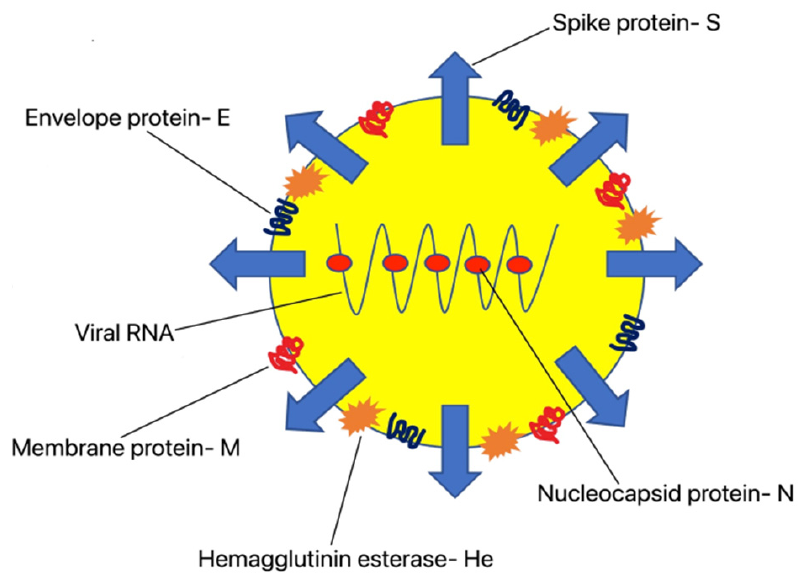
Figure 1. A model of COVID-19 depicting structural elements of the virion.